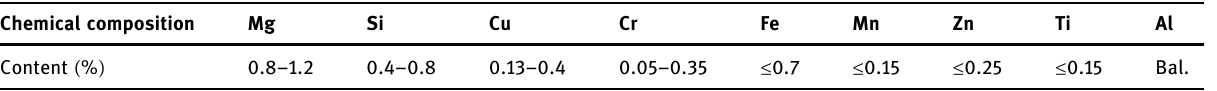
Table 2: Chemical composition of 6061 - T6 aluminium alloy ( mass fraction, % )